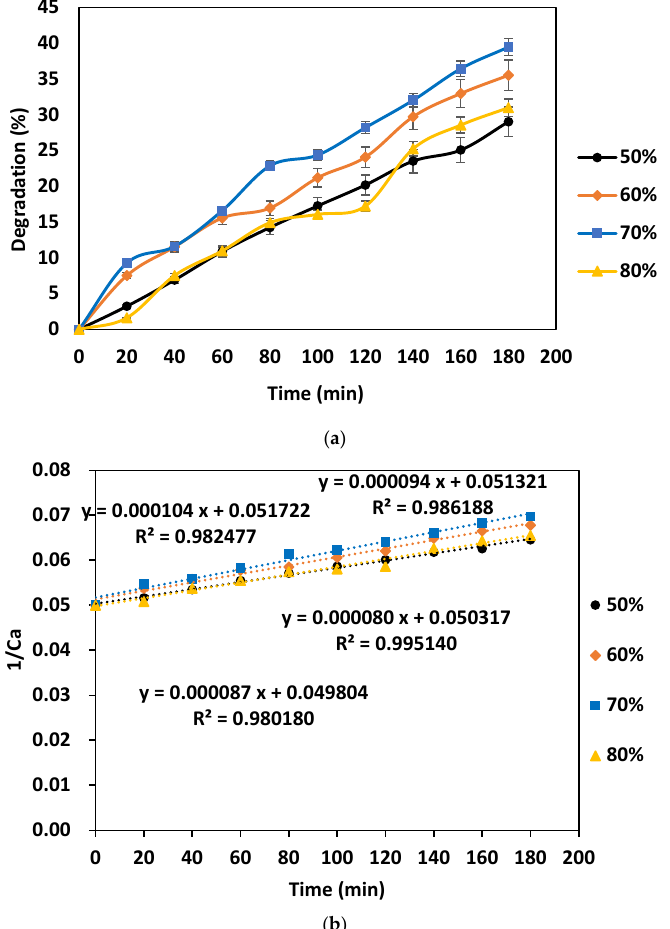
Figure 4. Effect of ultrasound duty cycle on the degradation of Chrysoidine R dye: ( a ) extent of degradation and ( b ) kinetic fitting.